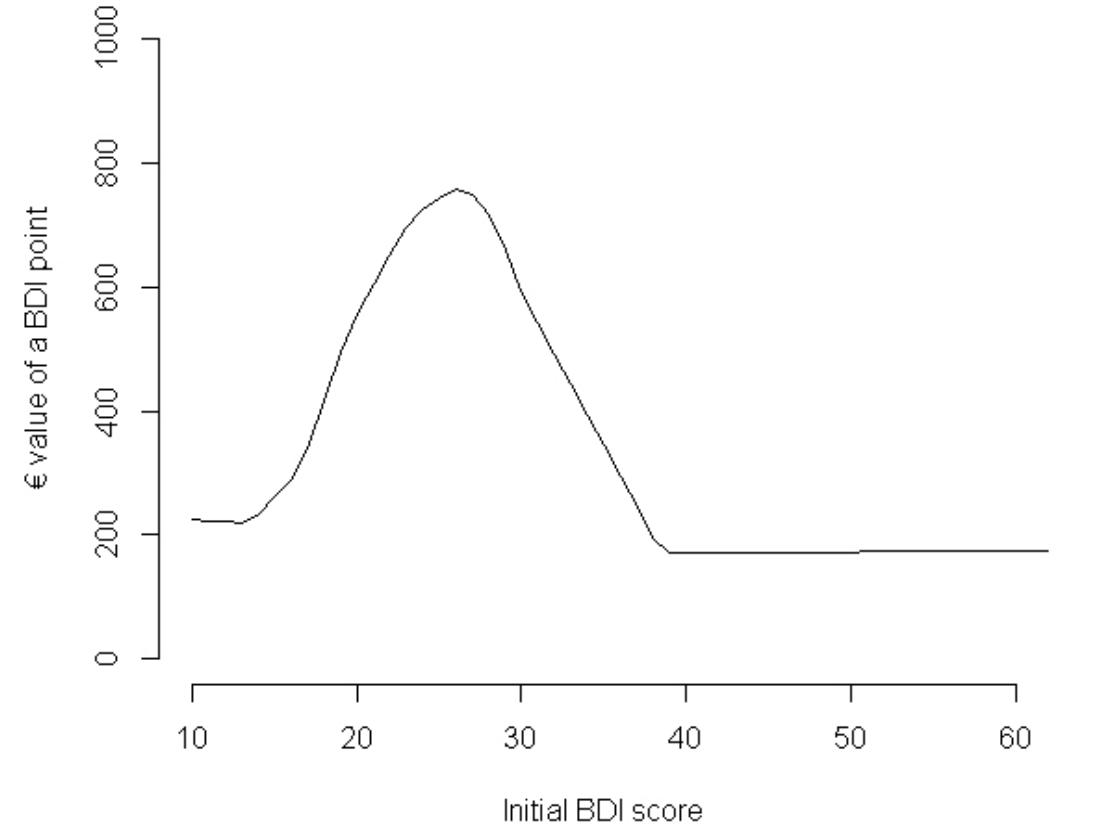
Figure 3. Value of a BDI point improvement (treatment minus control) as a function of the patient's initial BDI score (calculation based on a treatment effect of 10 BDI